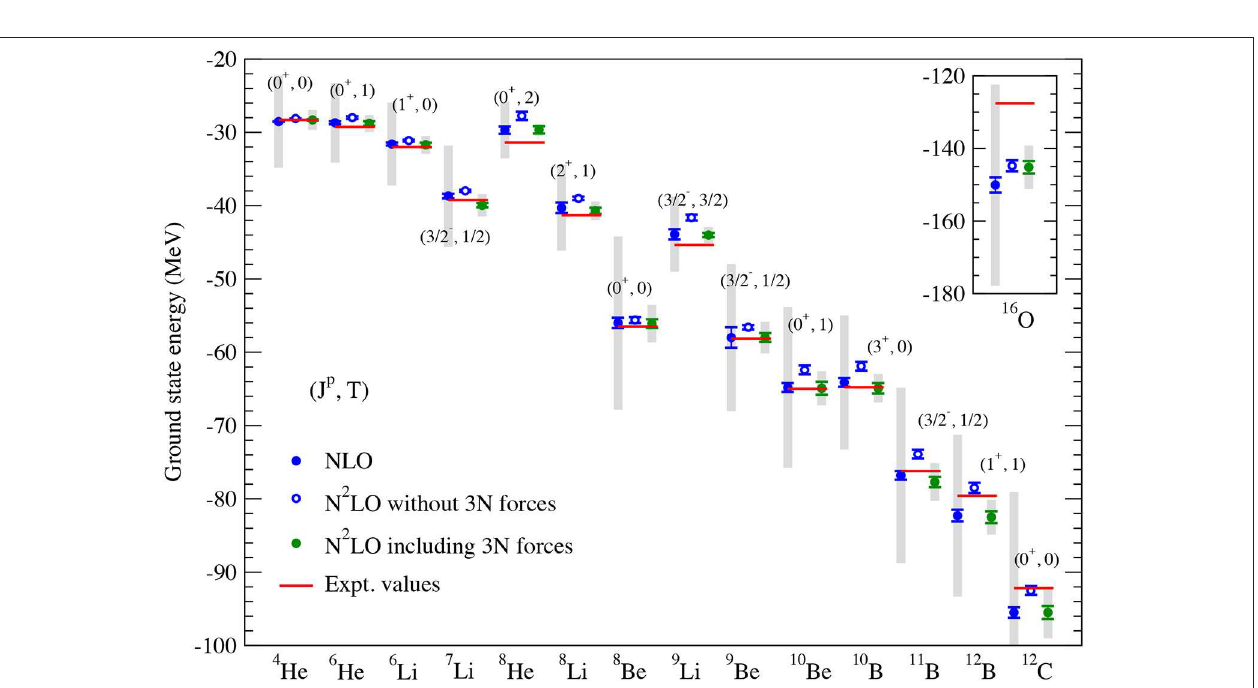
FIGURE 13 | Same as Figure 12 but for the deuteron-nucleon spin-correlation parameters C z , x , C y , y , C z , z , and C x , z for Nd elastic scattering at E N and E N 200 MeV (right) . Open circles are proton-deuteron data from von Przewoski et al. [ 192]. =